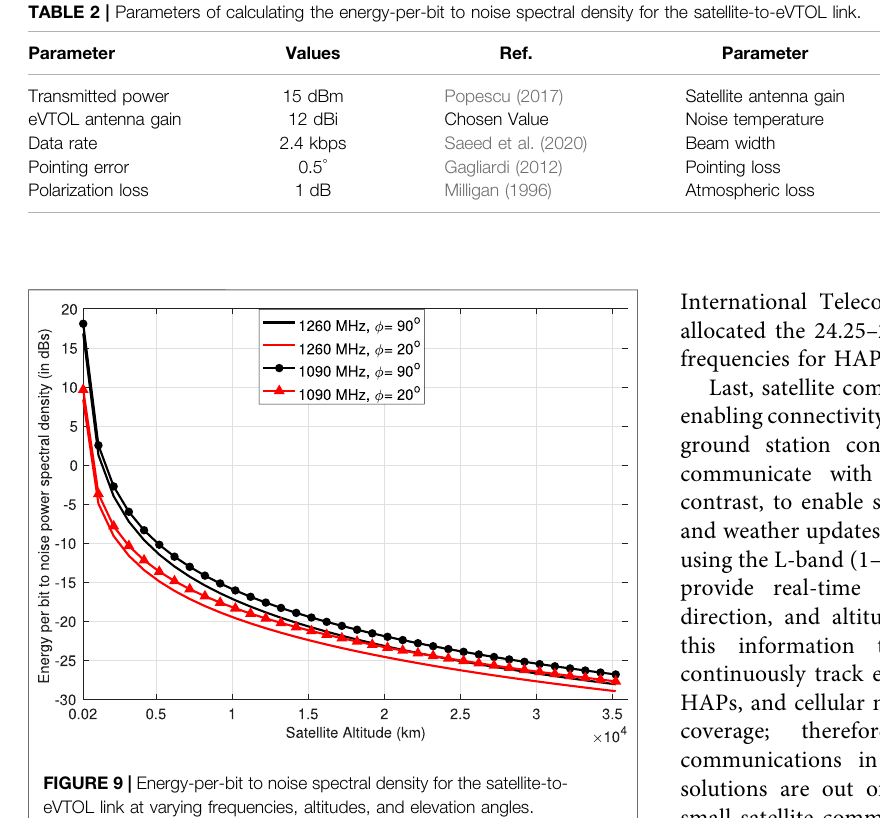
Frontiers in Communications and Networks |